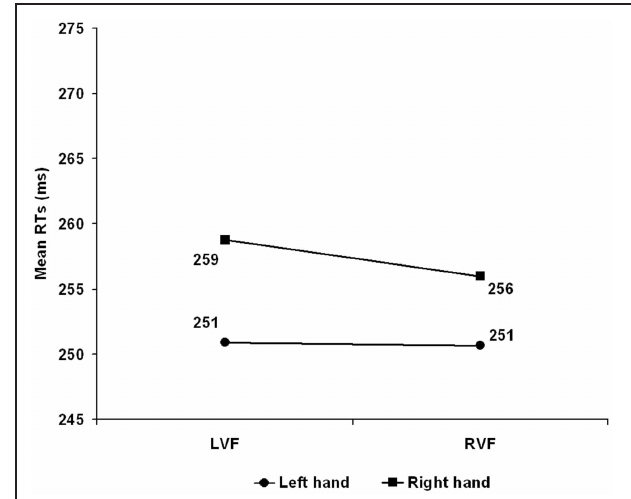
FIGURE 1 | Experiment 1: Right Handers. Mean reaction time (RT) as a function of visual hemifield of stimulus presentation and response hand. LVF, left visual field; RVF, right visual field. The asterisk indicates significant post-hoc test ( p < 0 . 025).